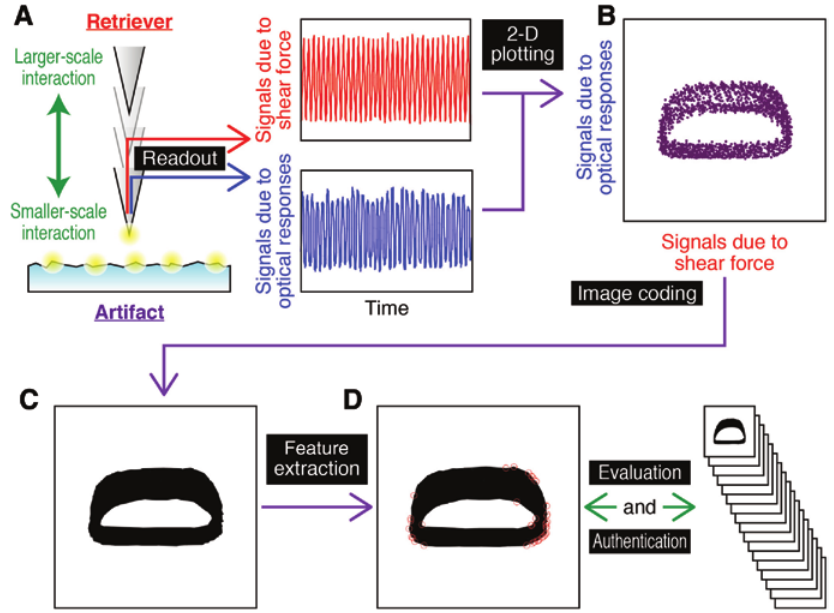
Figure 7: Basic procedure of non-scanning nanoretrieval: (A) subsequent sensing of the optical response and shear force, (B) producing two-dimensional plots of the obtained signals, (C) image coding to produce filled-in binary patterns of the plotted results, and (D) extraction of corner coordinates as a physical feature of each artifact. Source: Adapted with permission from Springer-Verlag: Appl. Phys. A